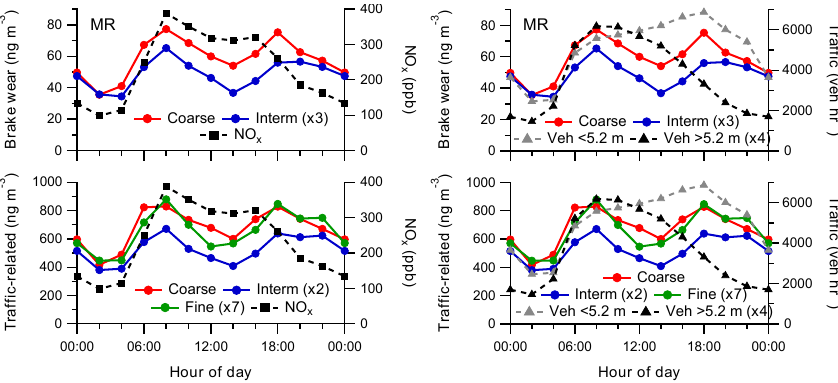
Figure 6. Diurnal variations in the brake wear (PM 10–2 . 5 – coarse, PM 2 . 5–1 . 0 – intermediate) and other traffic-related (coarse, intermediate, PM 1 . 0–0 . 3 – fine) factors at MR compared to diurnal variations of NO x (left) and traffic flow (right). Hour of day is start of a 2h sampling period (00:00UTC means sampling from 00:00 to 02:00UTC). Note the scaling applied to several tracers.